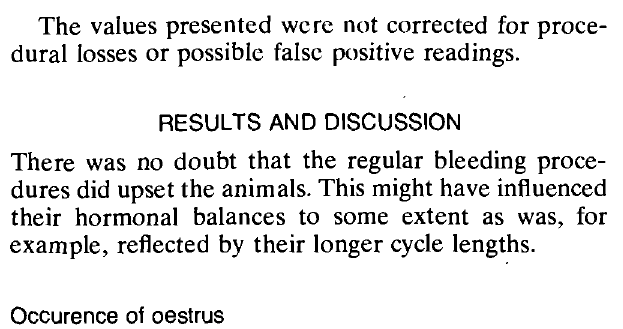
Table 2: THE ESTIMATED PROGESTERONE LEVELS IN STANDARD SOLUTIONS WITH LOW PROGESTERONE CONTENT WITHOUT ETHER EXTRACTION